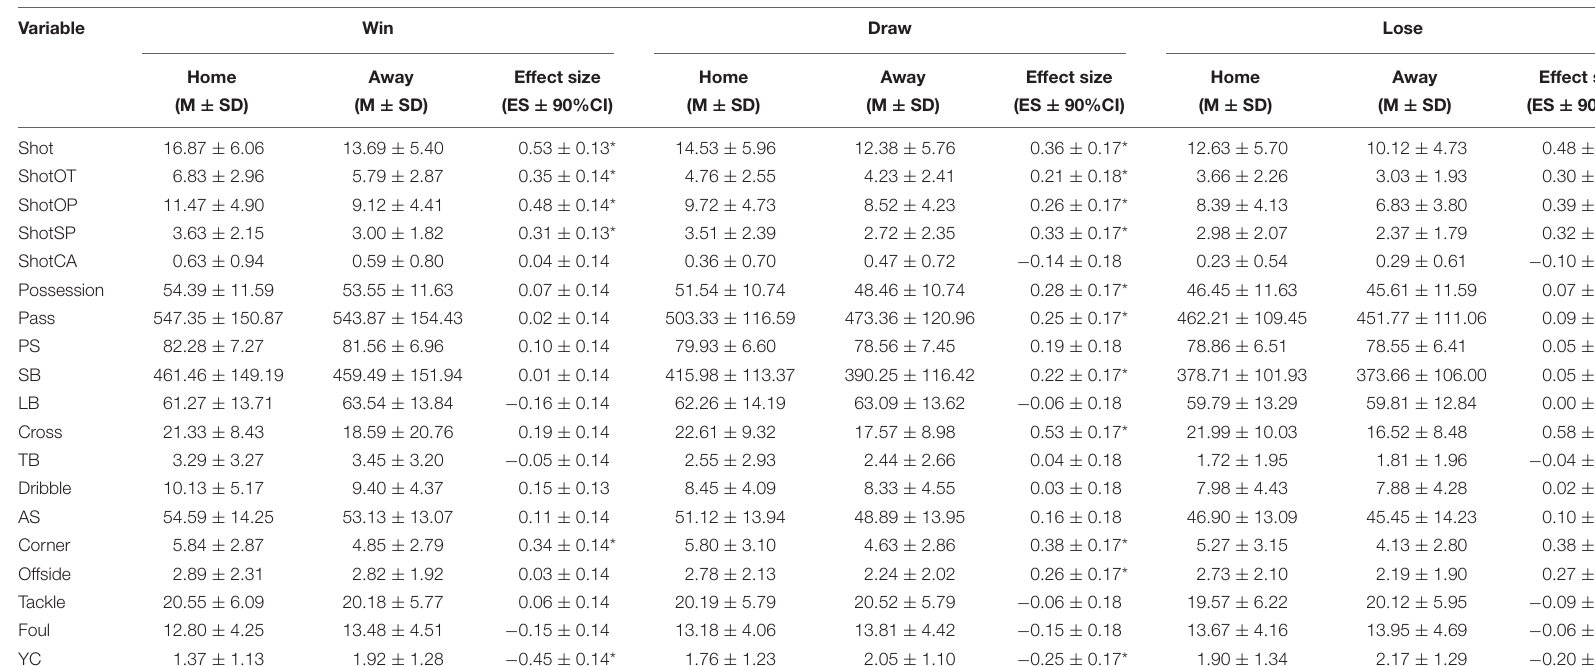
Descriptive statistics of teams in Tables 2 – 5 are presented as mean ± standard deviation (M ± SD). Effect sizes (ES) are presented as the magnitude of the true difference in means ± 90% confidence interval. Asterisks indicate that the p-value is lower than the significance level of 0.05. Abbreviations: ShotOT, shot on target; ShotOP, shot from open play; ShotSP, shot from set piece; ShotCA, shot from counter-attack; PS,